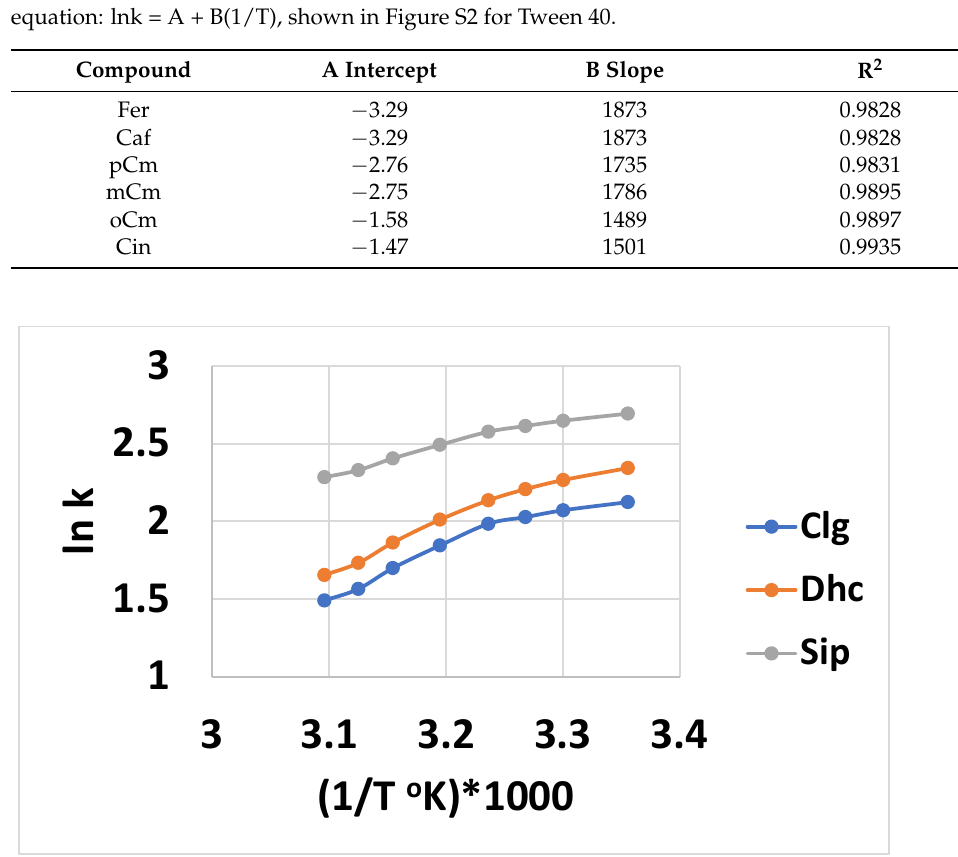
Table 3. Coefficients A and B with correlation coefficients (R 2 ) for plots based on the van’t Hoff